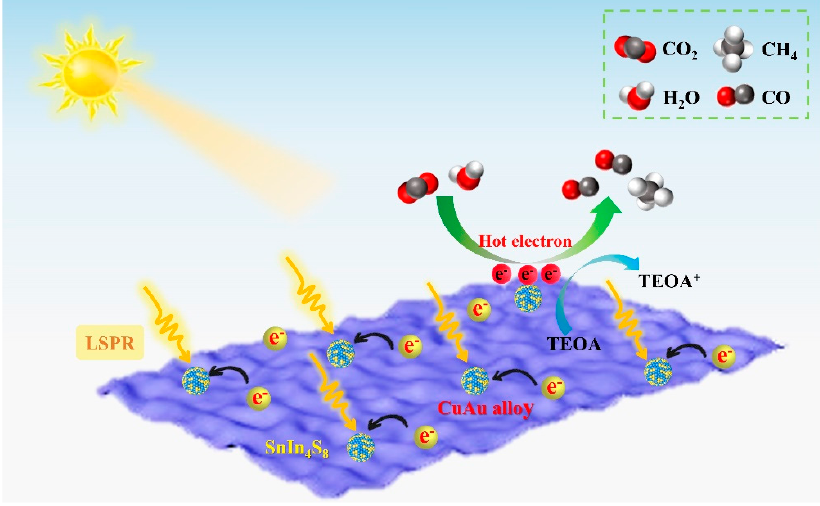
Figure 8. Schematic illustration of photocatalytic CO 2 reduction process on CuAu-SnIn 4 S 8 .